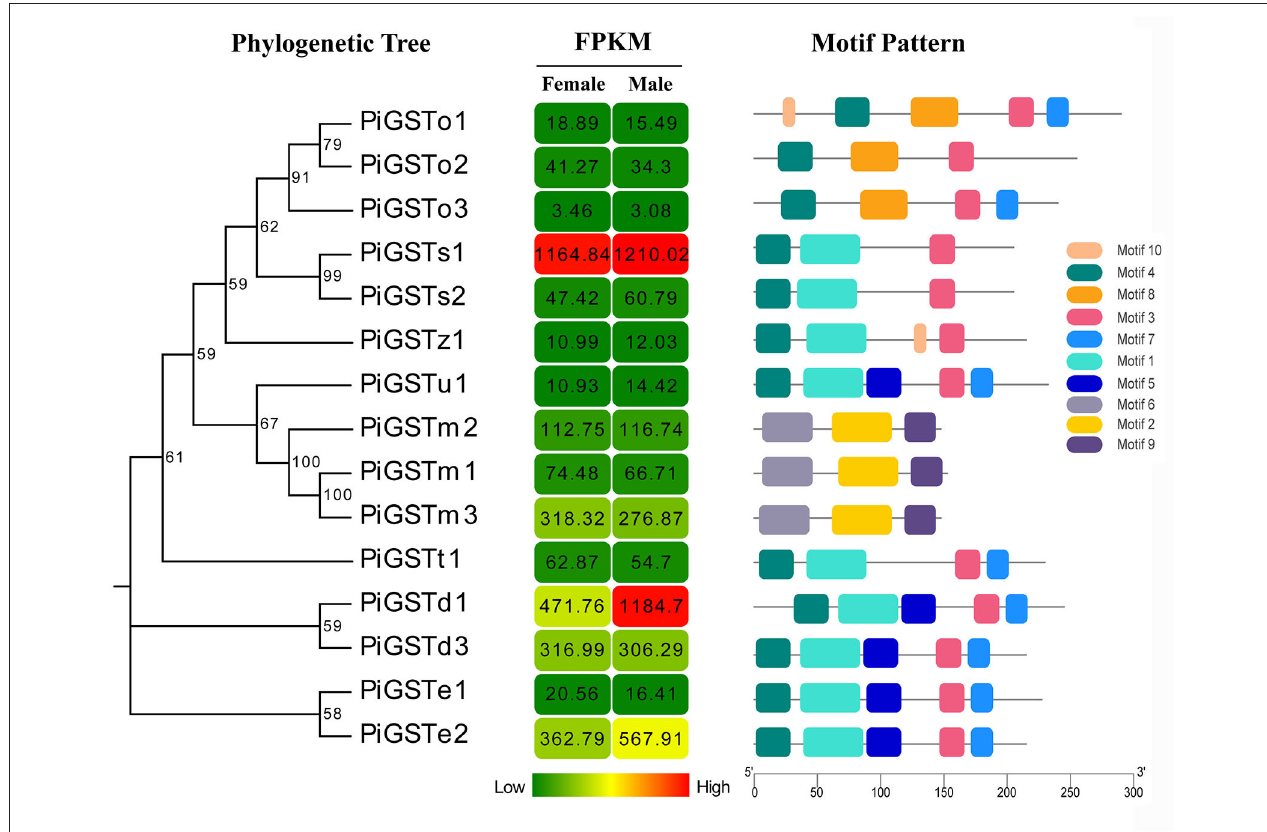
FIGURE 2 | Phylogenetic relationships, FPKM of PiGSTs, and architecture of the conserved motif patterns. The phylogenetic tree was constructed based on the full-length sequences of PiGSTs using MEGA 5.0 software. The sequence information for each motif is provided in Supplementary Figure 2 . The conserved motifs are displayed in colored boxes, and the length of protein can be estimated using the scale at the bottom.